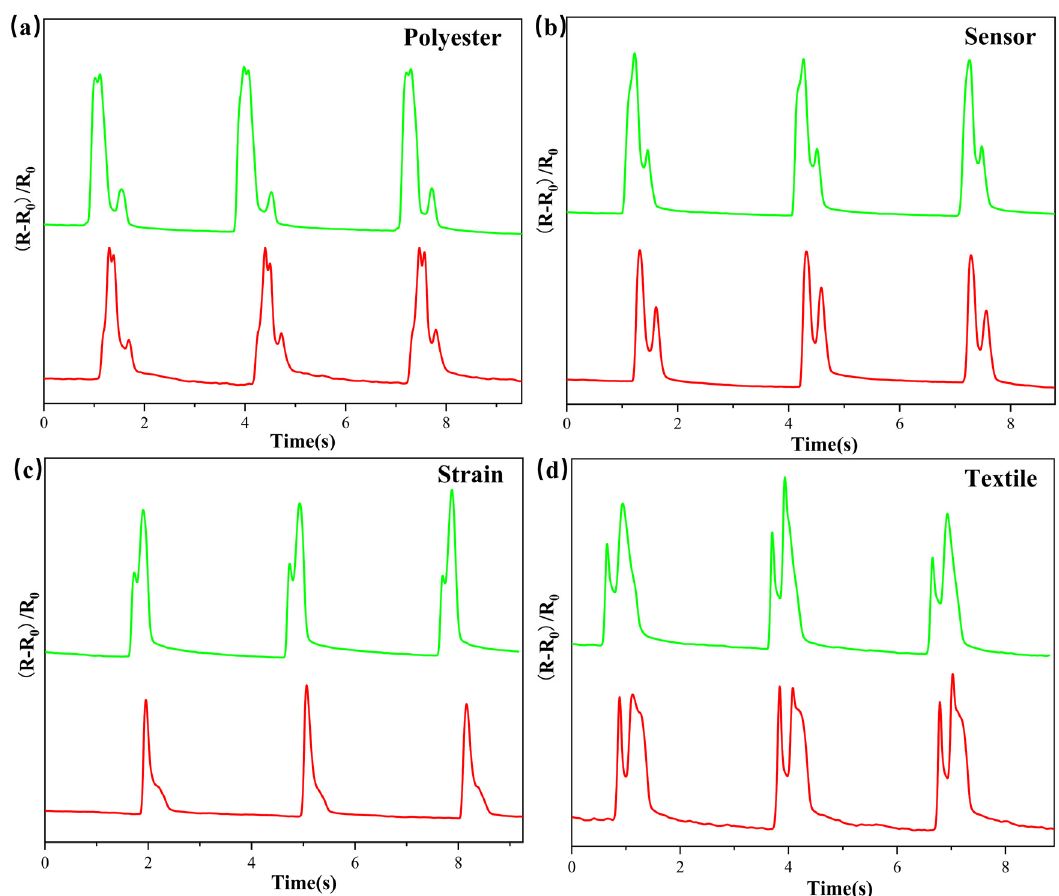
Figure 6. The relative resistance changes of the same word played by the loudspeaker under different pronunciation modes (red color: American English; green color: British English): ( a ) polyester; ( b ) sensor; ( c ) strain; ( d ) textile.